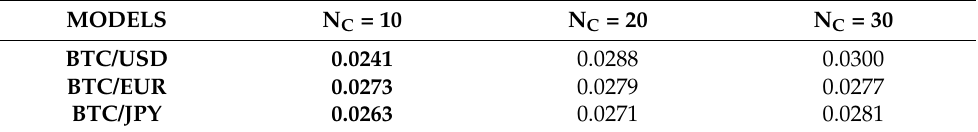
Table 11. Minimum RMSE for CMCMA model using different values for maximum number of climb. MODELS